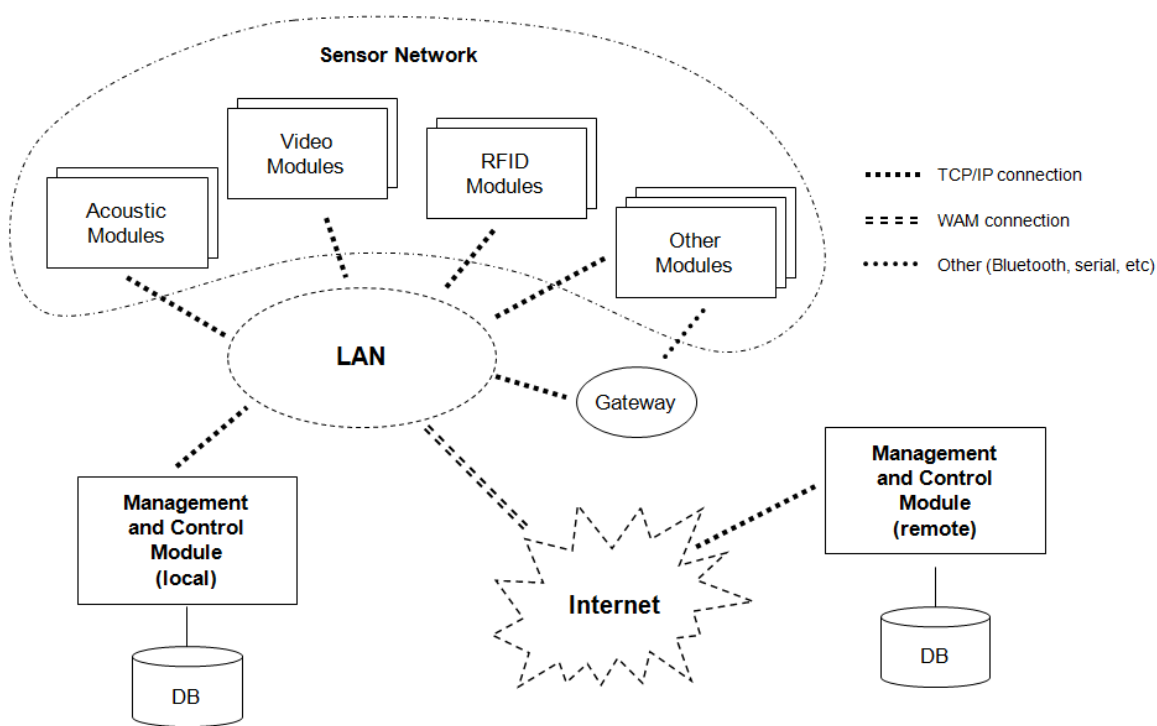
Figure 1. Block diagram of the